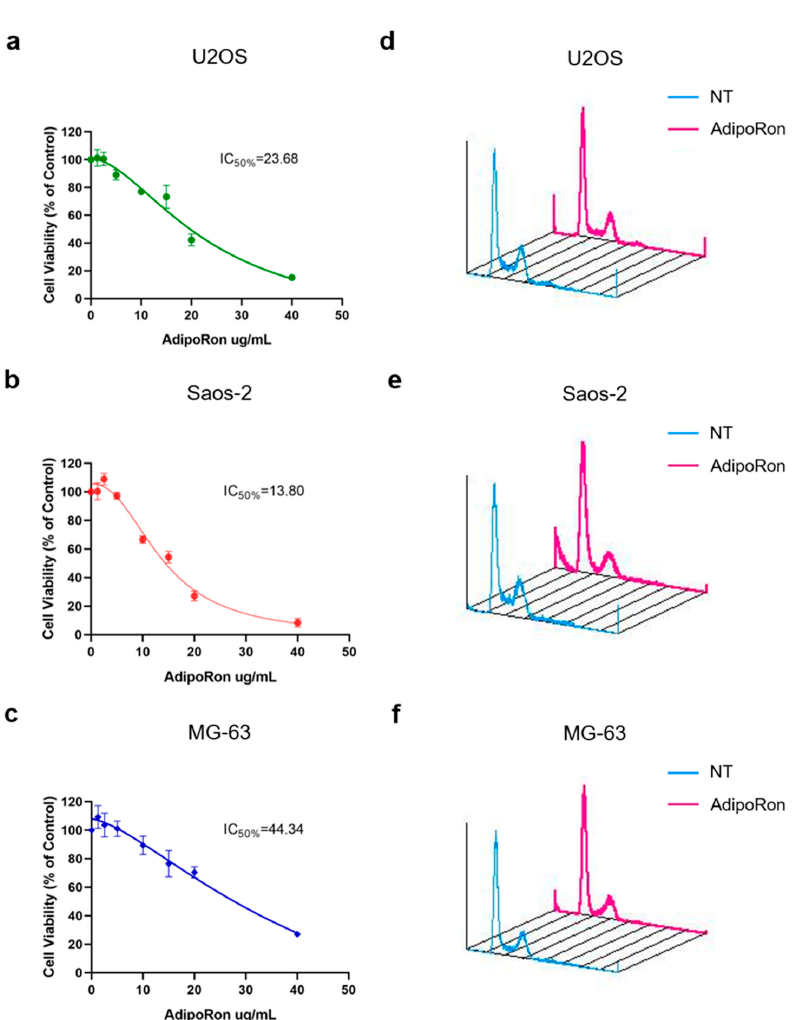
Figure 1. Effects of AdipoRon treatment on cell viability and cell cycle distribution in Osteosarcoma cells. U2OS ( a ), Saos-2 ( b ) and MG-63 ( c ) were supplemented with AdipoRon (from 1.25 μ g/mL to 40 μ g/mL) for 72 h in order to assess both cell viability and IC50 by MTT assay. U2OS ( d ), Saos-2 ( e ) and MG-63 ( f ) were grown in presence and absence of 20 μ g/mL AdipoRon for 48 h and then compared for cell phase distribution by FACS analysis. Data reported in the figure above have already been published [61].